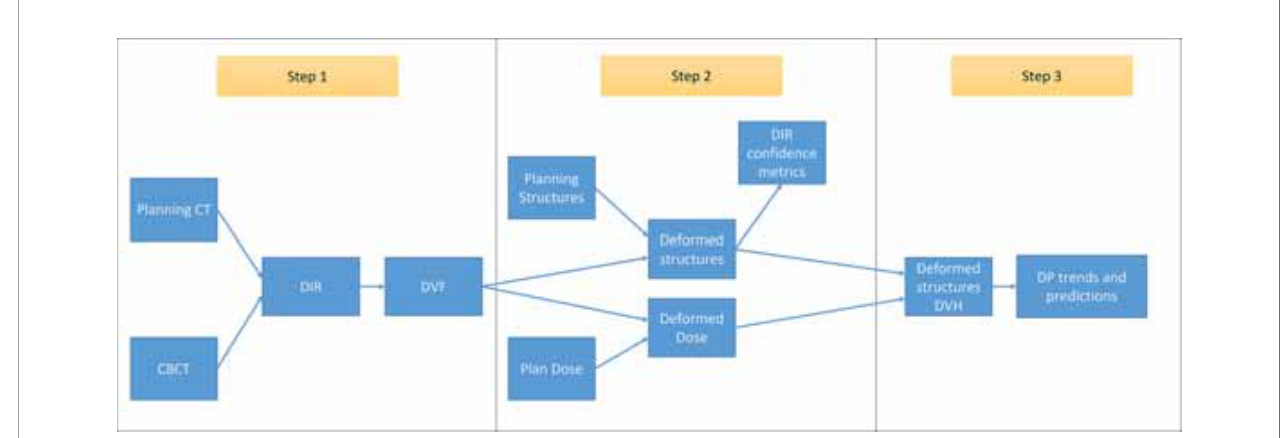
FIGURE 2 | Schematic of RTapp work fl ow divided into three steps: 1, generation of the deformation vector fi eld (DVF) from the deformable registration of planning CT to daily CBCT anatomy; 2, deformation of initial plan structures and dose based on daily DVF; and 3, generation of deformed structures DVH and trend and prediction of dosimetric